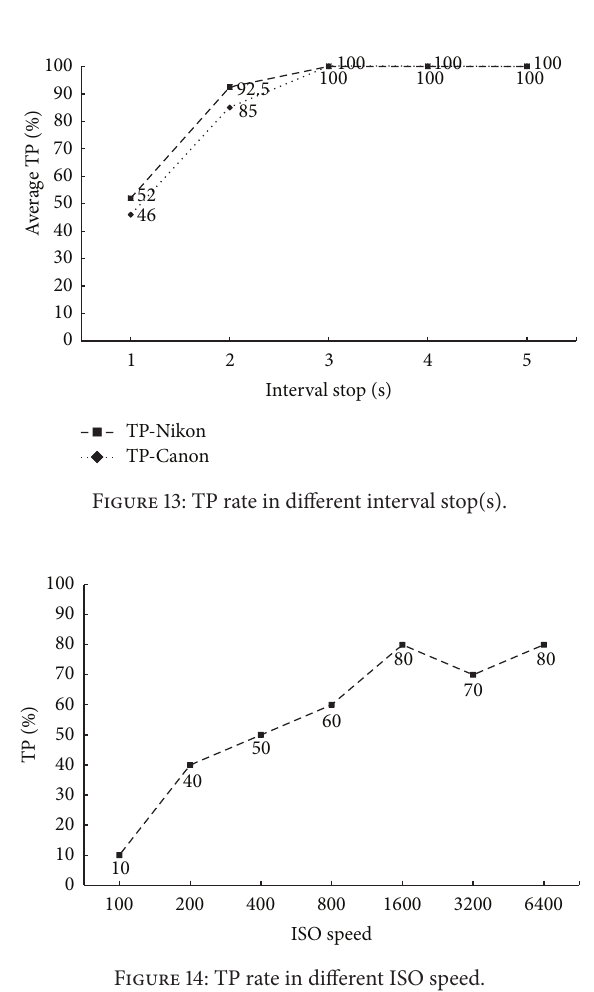
∗ not verified in experiment.